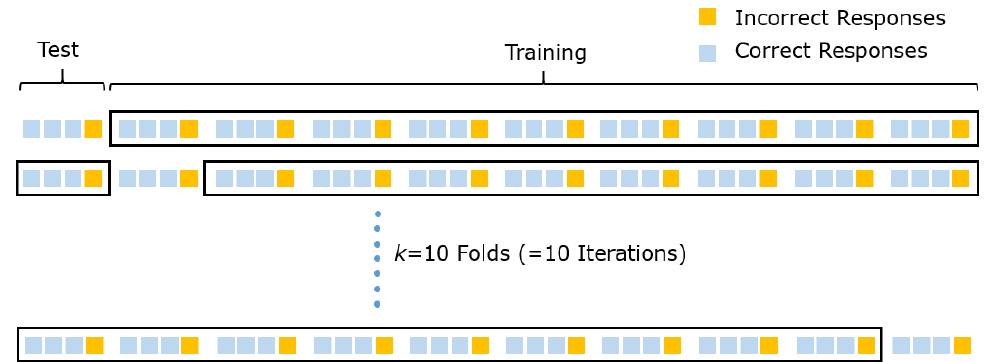
Figure 4. Stratified 10-fold cross-validation with 75% correct and 25% incorrect responses (without repetitions).